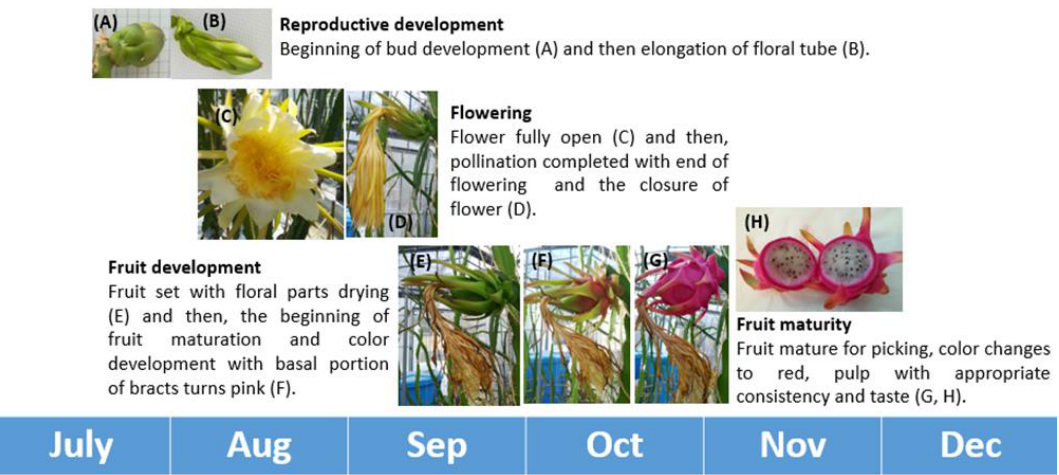
Figure 8. ( A – H ) Sequential illustrations progression of reproductive development, flowering, fruit development and maturation of dragon fruit ( H. undatus ) according to the extended BBCH scale from Kishore et al. (2016). Time elapsed in each stage (horizontal bar), (2018–2020). Reproductive development ( A , B ); Flowering ( C , D ); Fruit development ( E , F ); Fruit maturity ( G , H ).